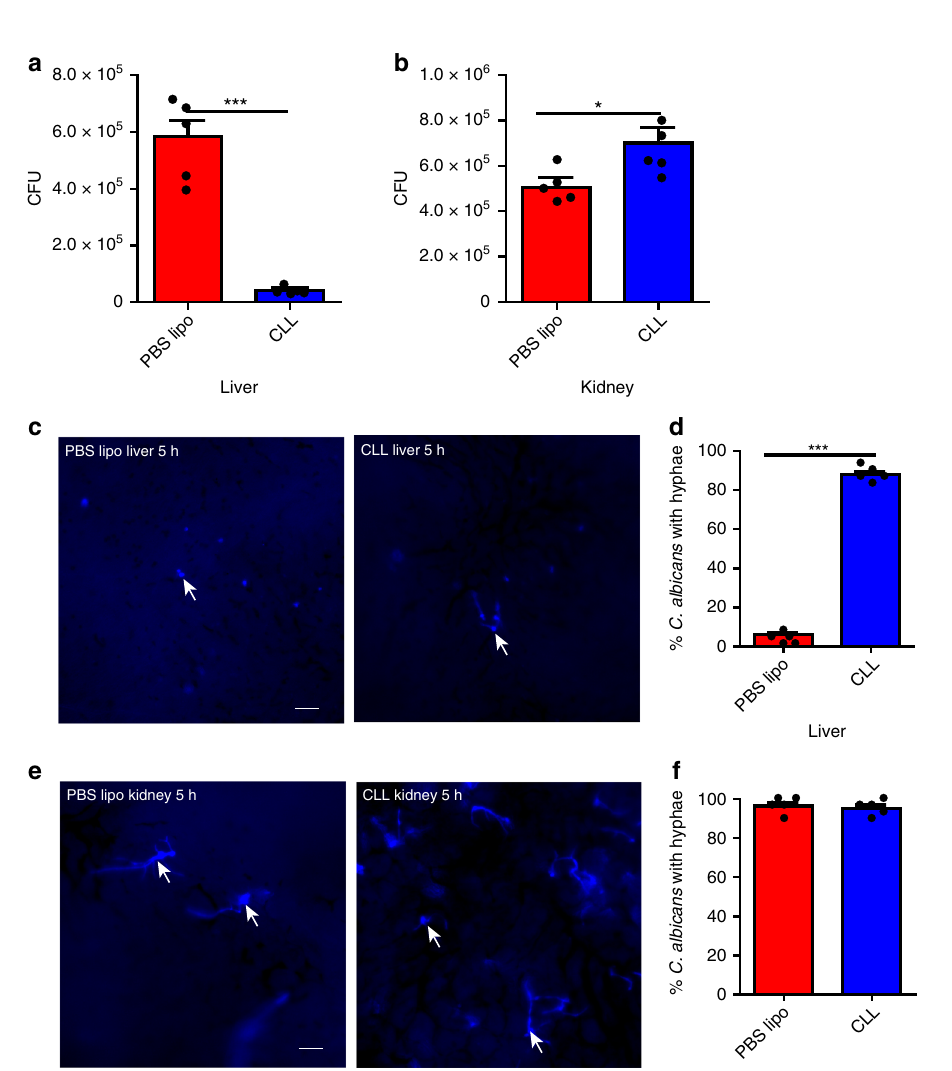
Fig. 6 KCs suppress the growth of C. neoformans in an IFN- γ -independent manner. a Representative images showing the growth of C. neoformans in different organs 3 days after i.v. infection with 20 × 10 6 GFP-labeled C. neoformans . b The number of C. neoformans per colony at various time points after infection. c Mice were treated with CLL or PBS lipo and 24 h later i.v. infected with 20 × 10 6 GFP-labeled C. neoformans . The yeast cells at each colony were counted in the liver 3 days post infection. Left panel: representative images showing the growth of C. neoformans ; right panel: the number of C. neoformans per colony. d The percentage of C. neoformans growing in the liver of mice treated with CLL or PBS lipo following i.v. infection of 20 × 10 6 GFP-labeled C. neoformans . e Representative IVM images showing clusters of iNKT cells in the liver of CXCR6 gfp/ + mice 0, 2, and 5 days post i.v. infection with 20 × 10 6 C. neoformans . f The size of iNKT cell clusters in the liver of CXCR6 gfp/ + mice 0, 2, and 5 days post i.v. infection with 20 × 10 6 C. neoformans . g IFN- γ amounts in the liver homogenates of mice i.v. infected with 20 × 10 6 C. neoformans . h The expression of IFN- γ R on KCs of WT but not IFN- γ R − / − mice (gated CD45 + F4/80 + CD11b int population). i WT and IFN- γ R − / − mice were i.v. infected with 20 × 10 6 GFP-labeled C. neoformans . The fungal growth was assessed by counting the yeast cells at each colony in the liver 2 and 5 days after infection. j The fungal burdens in different organs of WT and IFN- γ R − / − mice 5 days following i.v. infection with 1 × 10 6 C. neoformans . Data from different fi eld of views of mice ( n = 5 mice/ group) were pooled together ( b , c , f , i ). Data are from biologically distinct samples ( n = 5 mice/group, d , g , j ). Scale bars: 25 µ m. Data are expressed as mean ± SEM of two independent experiments. * p < 0.05, ** p < 0.01, *** p < 0.001. NS: not signi fi cant. p values were calculated by one-way ANOVA followed by Tukey ’ s post hoc test ( d , f , g , i ) or Student ’ s t test ( c , j ). Source data are provided as a Source Data fi le